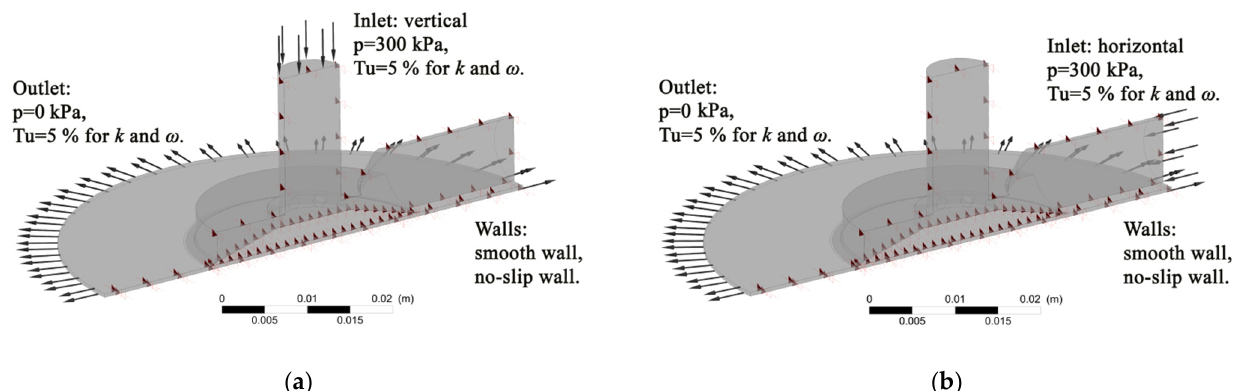
Figure 5. Extreme conditions for air flow models: ( a ) vertical inlet; ( b ) horizontal inlet.